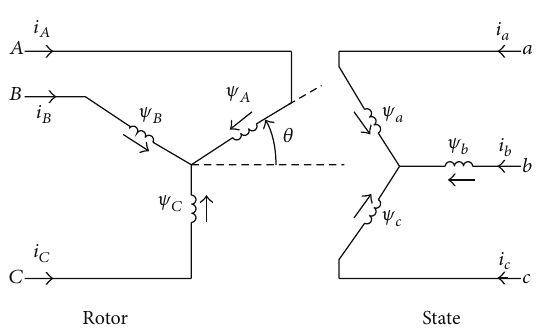
Figure 1: Stator and rotor circuits of an induction motor.